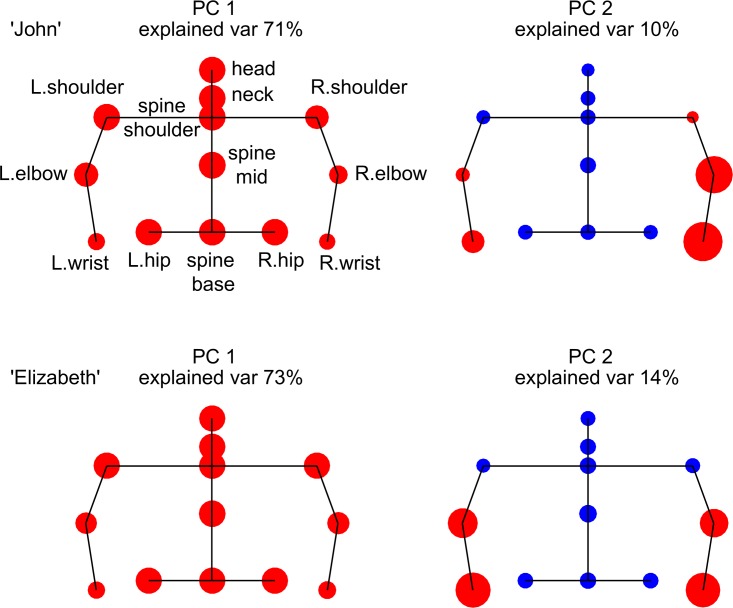
Principal components of the speed of 13 joints of individuals from different dyads.Circle size represents the magnitude of joints’ loadings in the PC. Color marks the sign of the loading: positive (red) or negative (blue). PC1 is similar across participants and corresponds to about equal loading in each upper body joint. PC2 is more variable between participants and shows loadings primarily on one or both arms.